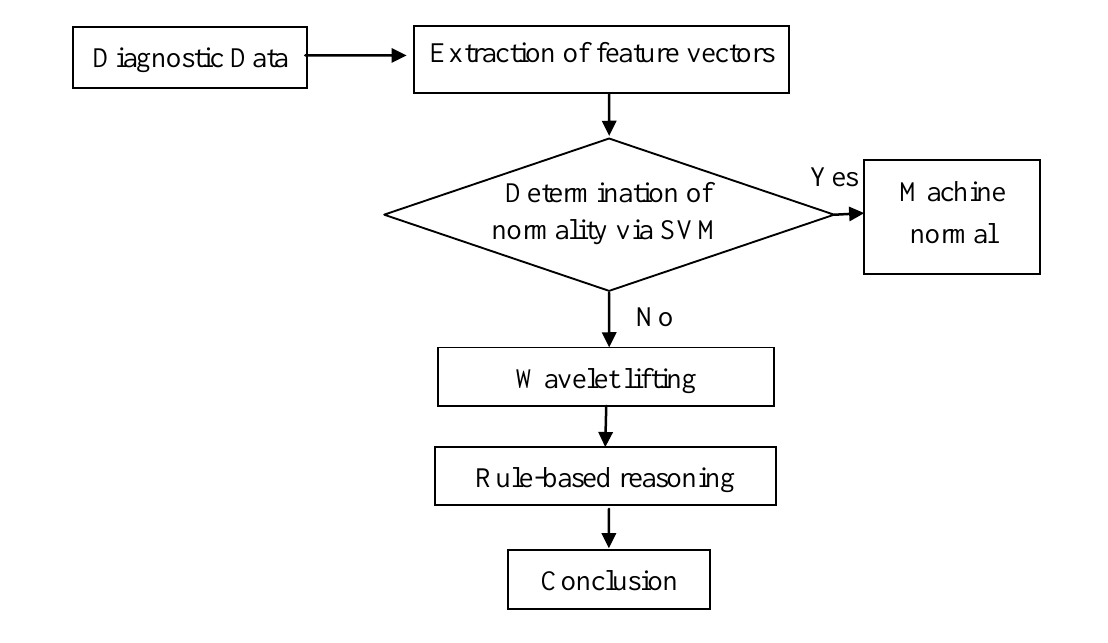
Figure 1. The principle of intelligent fault diagnosis based on SVM, wavelet lifting and